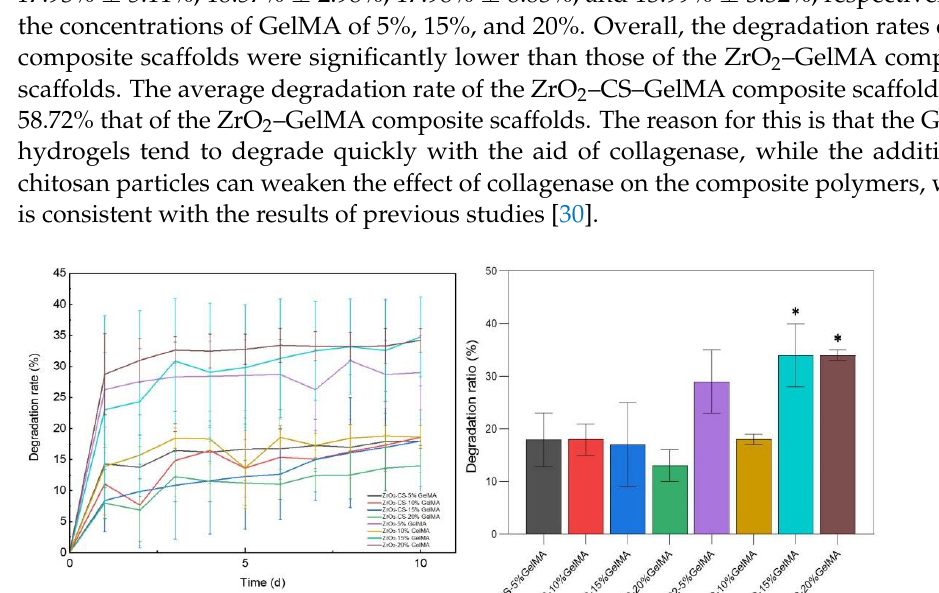
Figure 8. Compressive strength of porous zirconia scaffolds with composite scaffolds, * p < 0.05, ** p < 0.01, compared to ZrO 2 group.